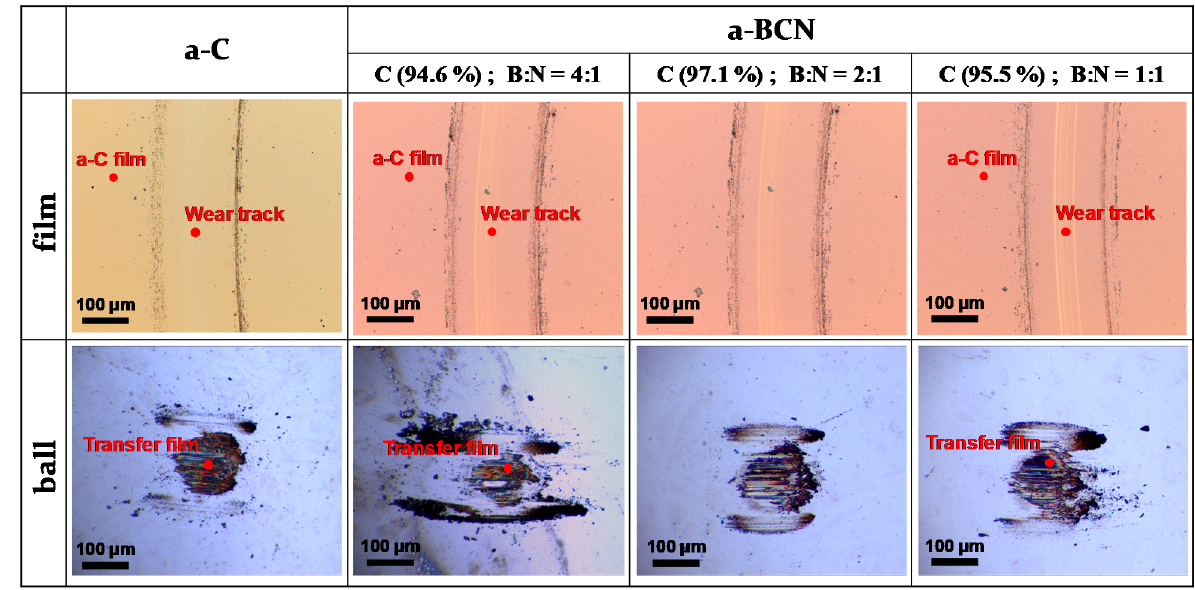
Figure 12. Optical microscope images of the wear track on the film and the wear spot on the ball sample.